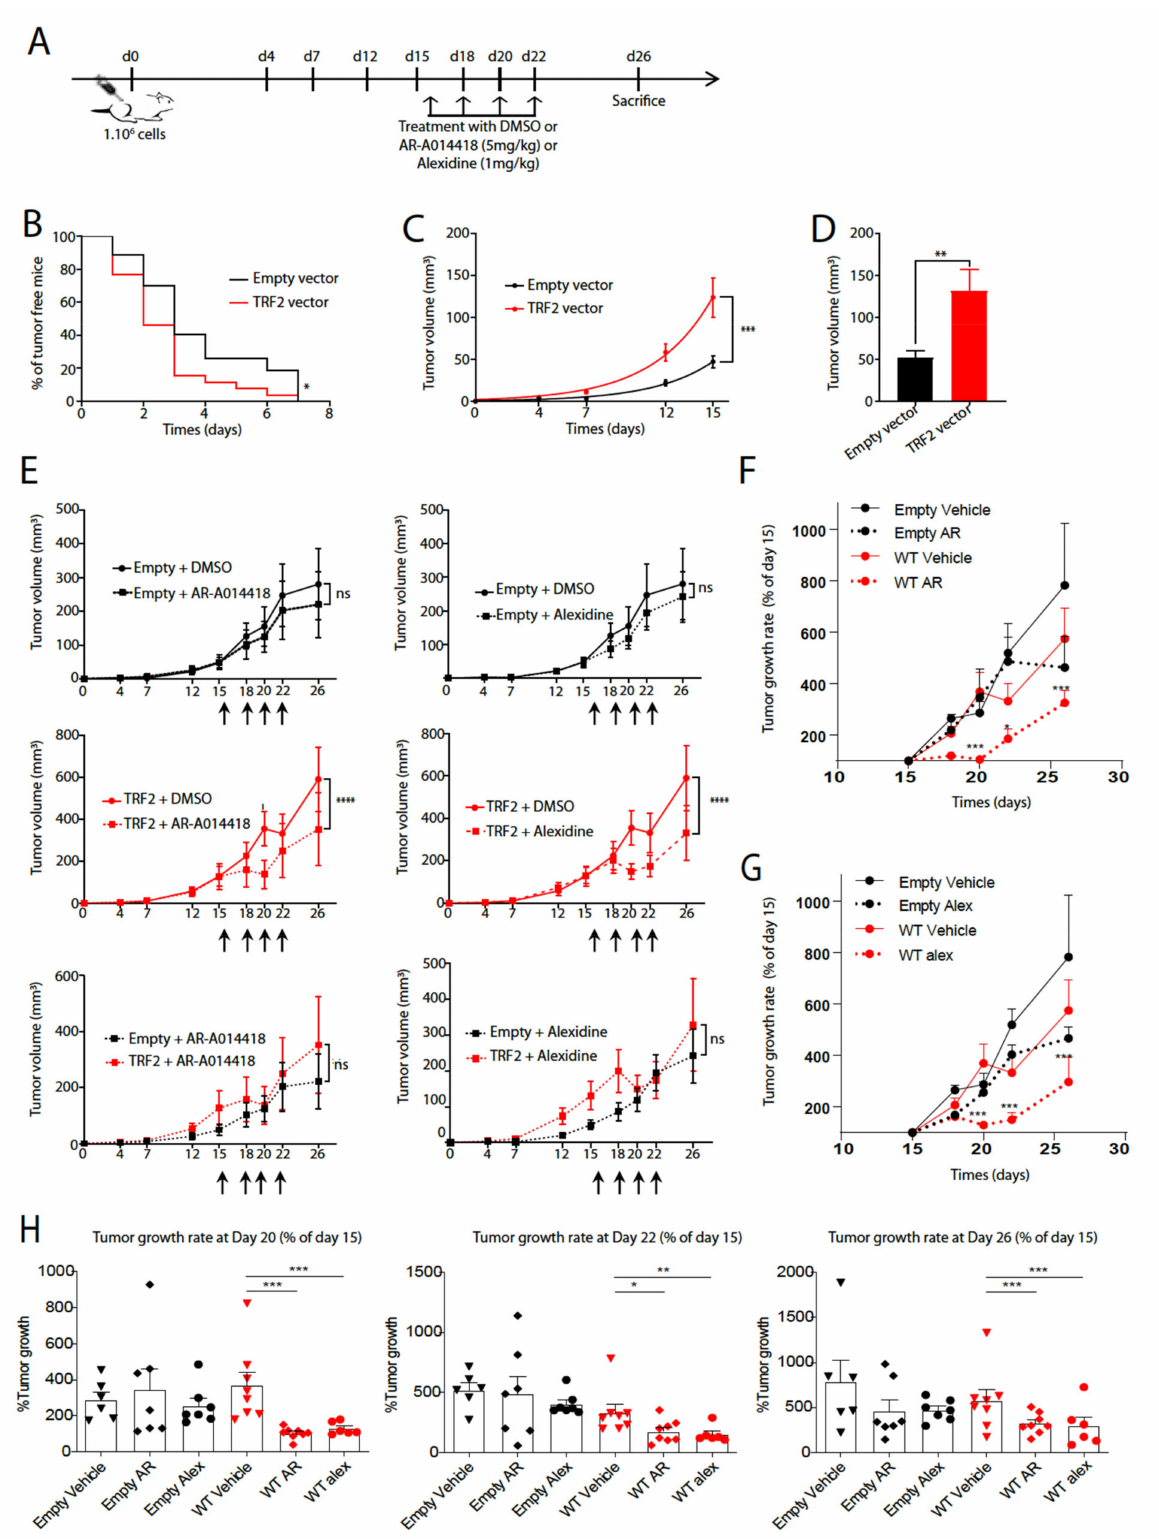
Figure 2. In vivo alexidine · 2HCl or AR-A014418 treatment inhibited TRF2-dependent tumorigenesis. ( A ) Schematic representation of the experimental design. BJ-HELTRas cells either overexpressing TRF2 (TRF2 vector) or not (empty